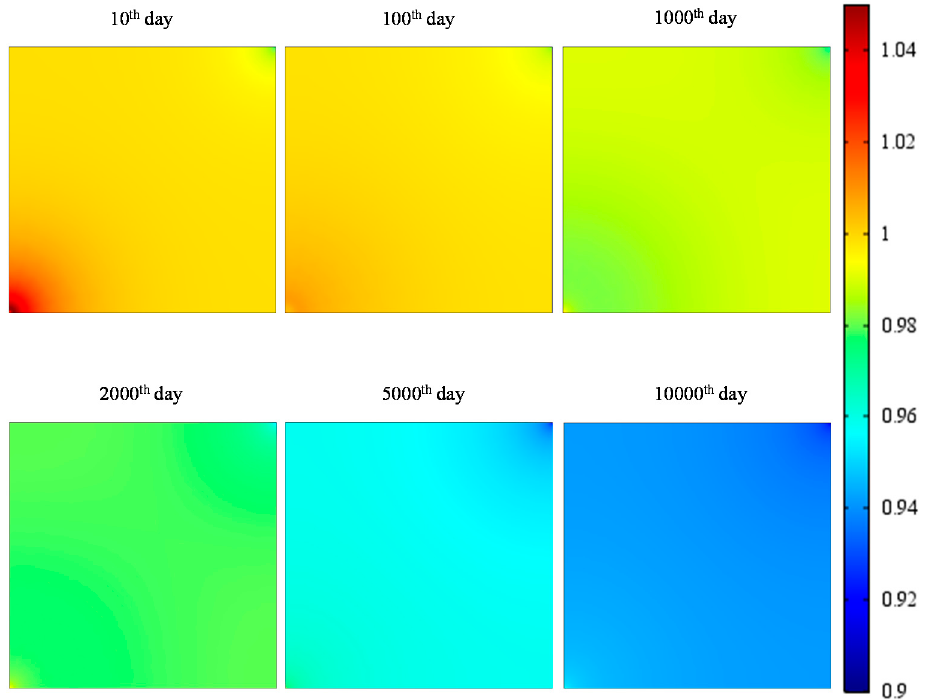
Figure 4. Matrix permeability evolution maps ( k m / k m 0 ) at different time.